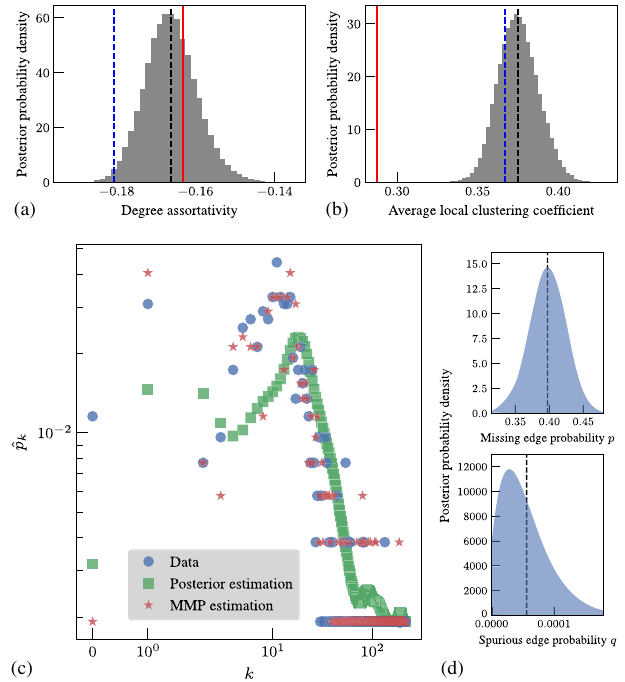
FIG. 10. Reconstruction statistics for the neural network of C. elegans . (a) Posterior distribution of the degree assortativity coefficient. The black dashed line marks the mean of the distribu- tion, and the blue dashed line the value obtained for the MMP ˆ A . The red solid line marks the value computed directly estimate fromthedata.(b)Thesameas(a)butfortheaveragelocalclustering coefficient. (c) Measured and estimated degree distributions. (d) Posterior distributions for the error probabilities p and q